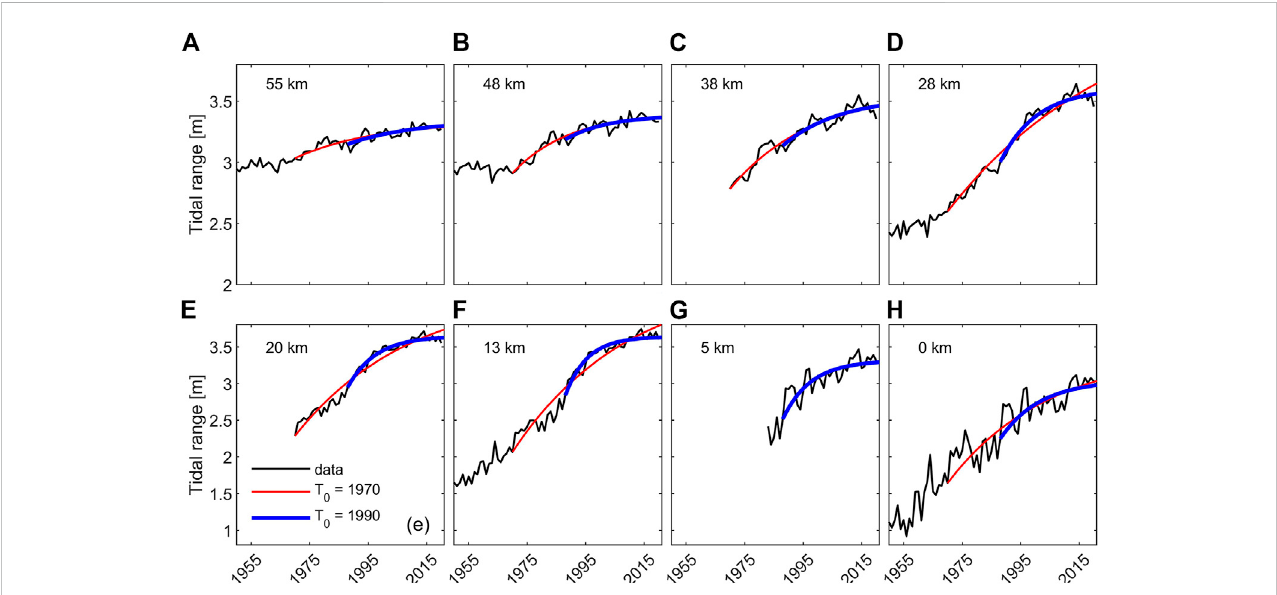
FIGURE 12 Observed(black)and fi tted(blueandred)increaseintidalrangeAovertime(panel (A – H) ,perstation)alongthelowerEmsRiver.Theredlineisa fi tofEq.